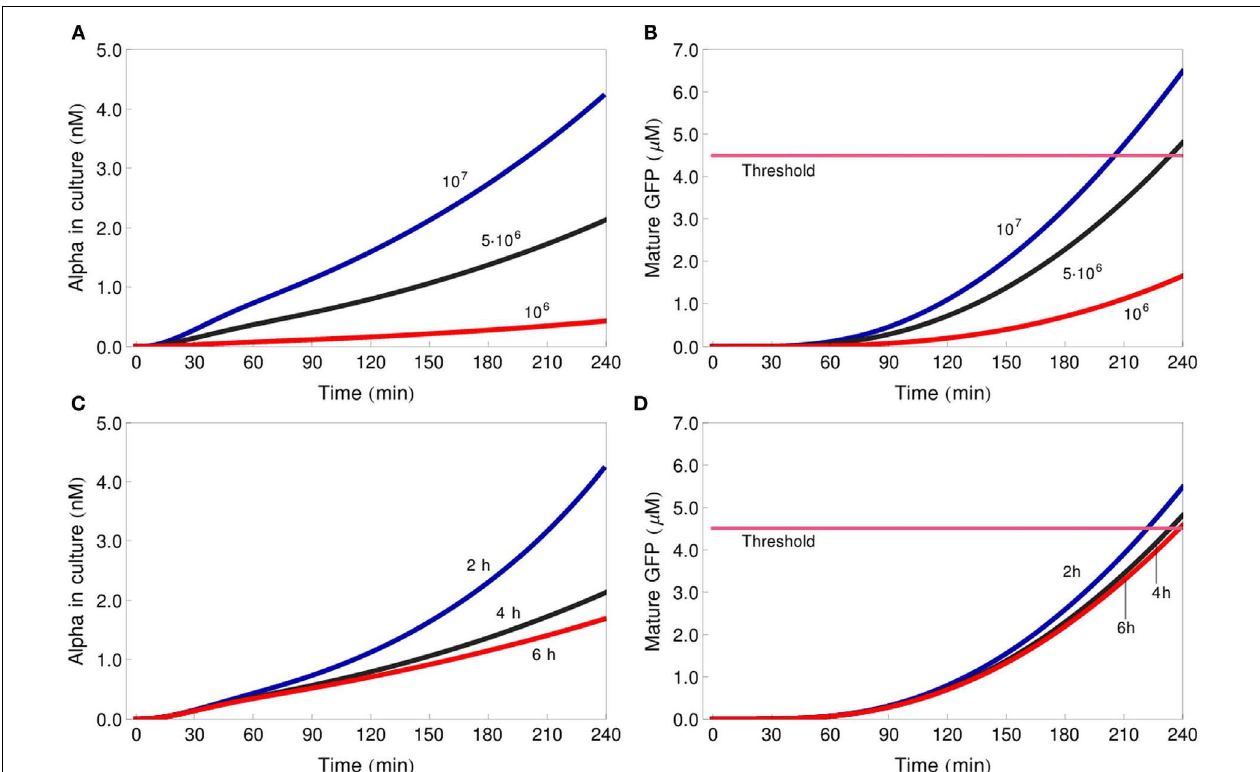
(black line), 10 7 cells/ml [blue line (A,B) ] and three different cell doubling times: 6h (red line), 4h (black line), 2h (blue line; C,D) . All simulations represent the IDENTITY gate treated with 0.4M NaCl.The pink line depicts the GFP-concentration